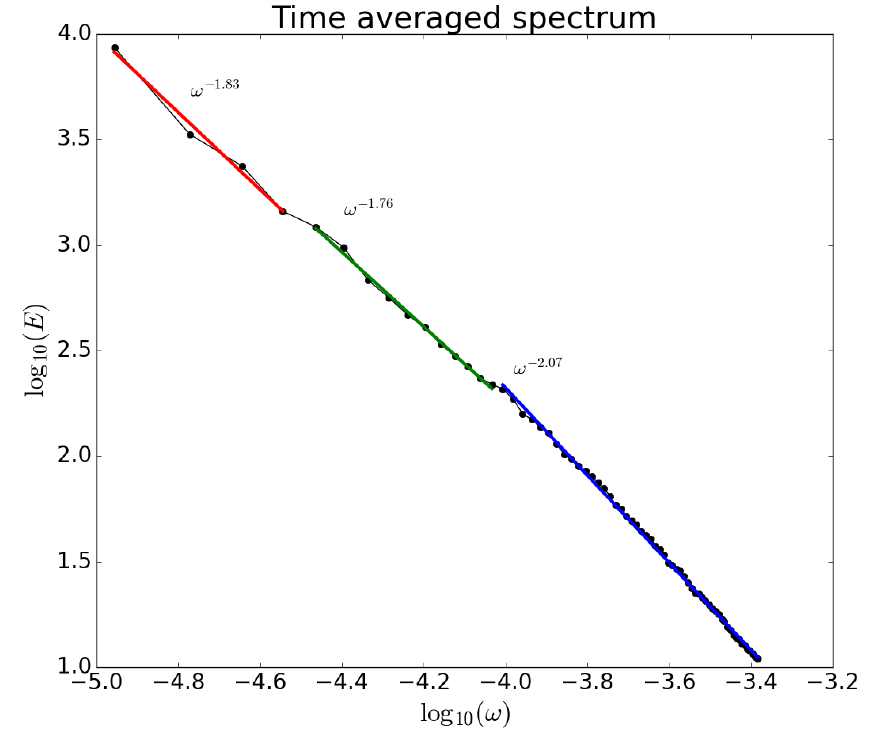
Figure 6. Energy spectrum calculated from the POD coefficients, which describe the temporal behav- ior of the evolution of the Faraji cyclone, with a three-scale separation. The exponents correspond to the spectral indices of each spectral